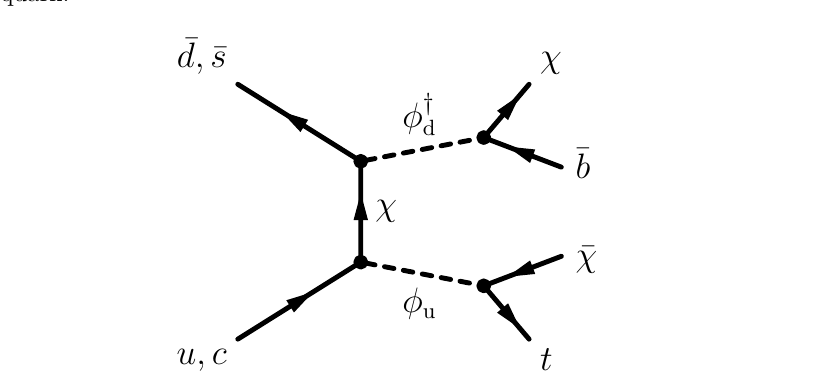
Figure 8 . Representative Feynman diagrams for the production of DM in association with a light jet and a top quark.